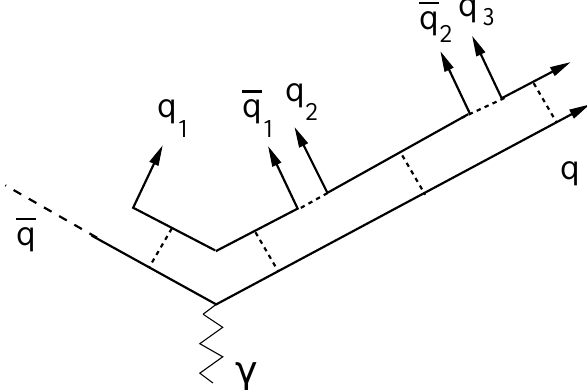
Figure 3. Sequential quark formation in the e + e − annihilation If the produced hadron ¯ q 1 q 2 consists of quarks of different masses, the resulting temperature has to be calculated as an average of the different accelerations